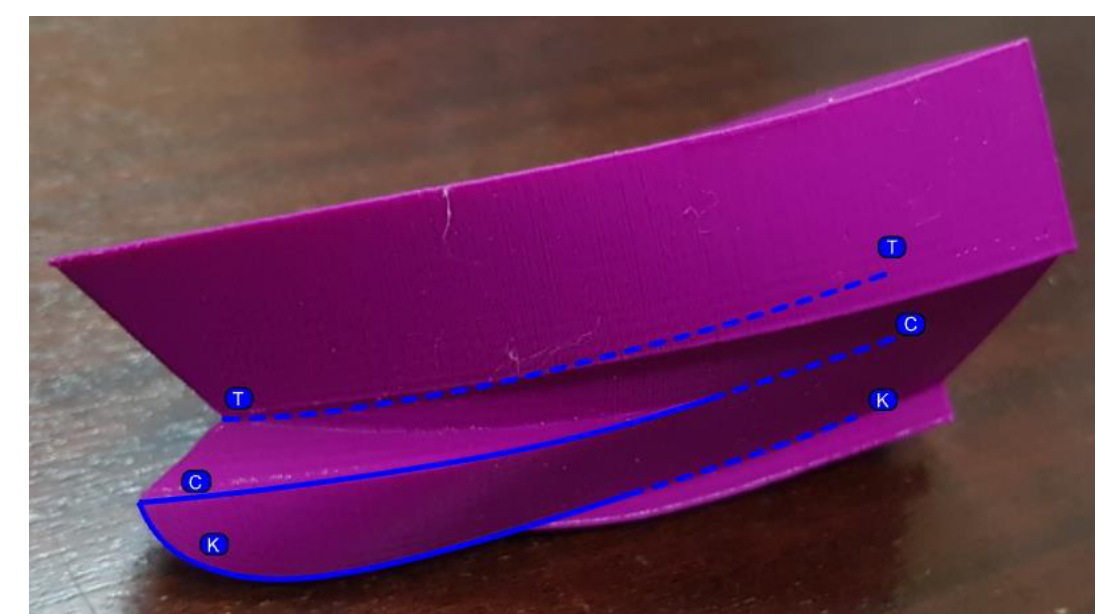
Figure 3. Geometric definition of a polyhedral Bulbous Bow.